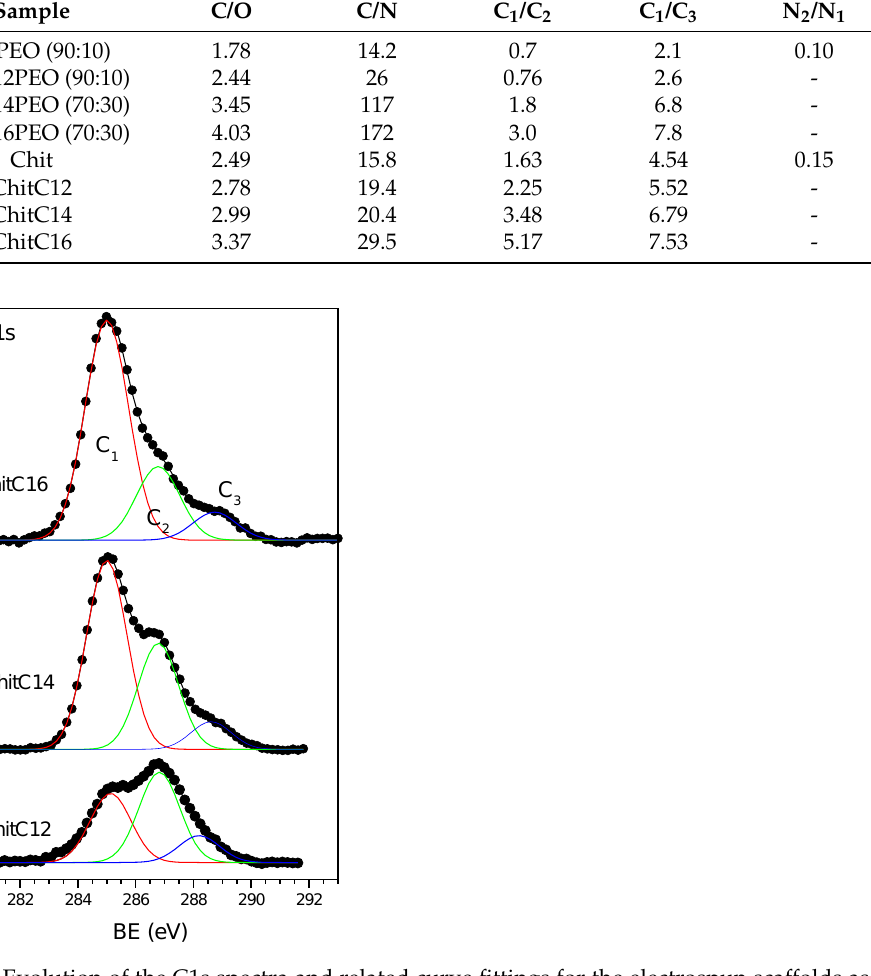
Figure 5. Evolution of the C1s spectra and related curve fittings for the electrospun scaffolds as a function of the aliphatic chain length. Markers represent experimental points, lines fitting components and calculated spectra.